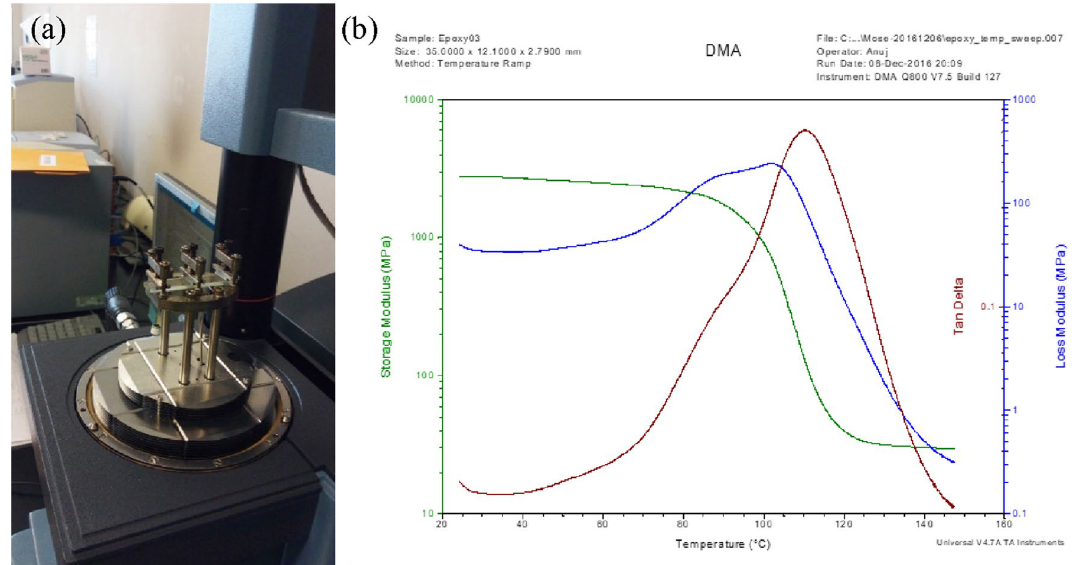
Figure 4. ( a ) DMA experimental set-up for three-point bending test at 1.0 Hz frequency in the temperature range from 25 °C to 150 °C and ( b ) thermo-optic curve of the photoelastic material showing the glass transition temperature 24